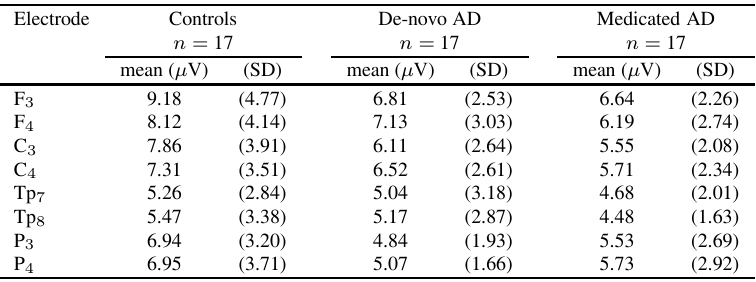
Table 3 Maximum amplitudes in auditory event-related oscillatory responses in Alzheimer’s disease (AD) and healthy elderly controls (repeated measures of ANOVA)* Electrode